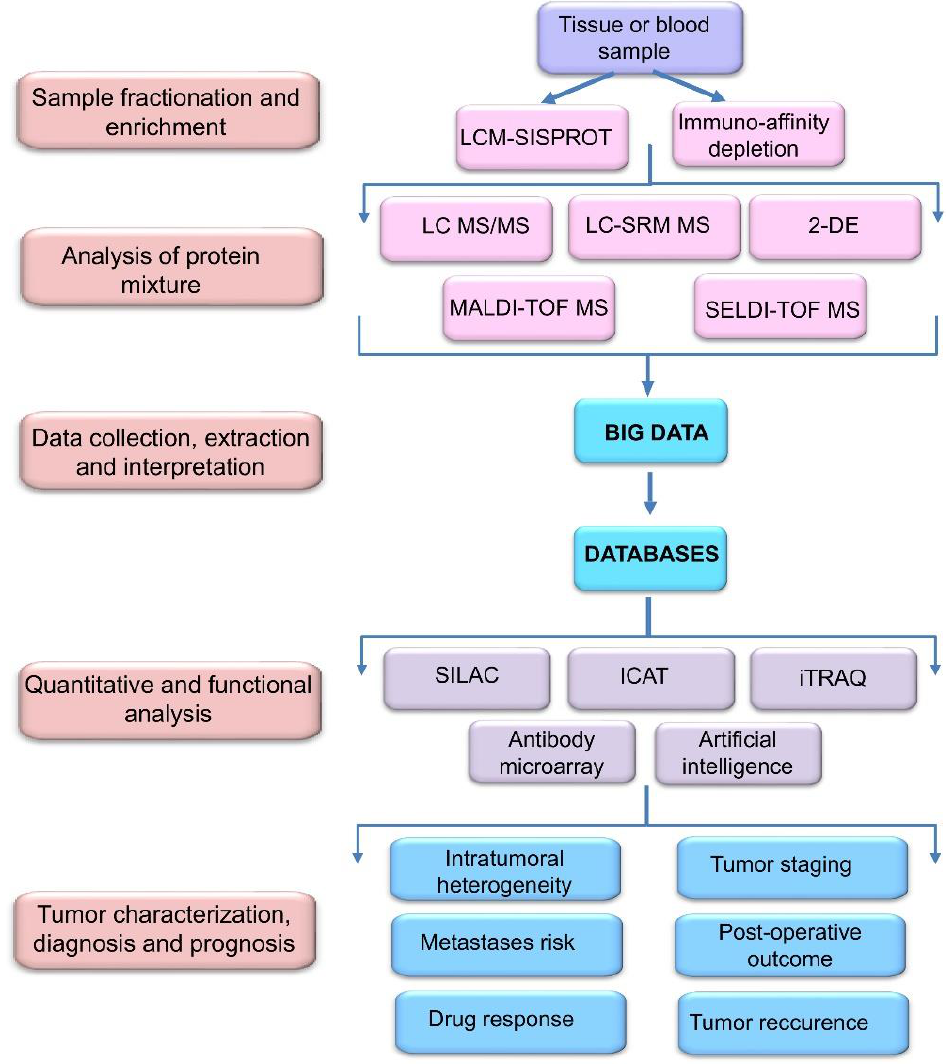
Figure 2. Workflow of biomarker identification, quantification, validation, and verification using proteomic profiling technologies. Tissue and blood samples are first fractionated and enriched using laser capture microdissection spintip-based proteomics (LCM-SISPROT) and immuno-affinity depletion. Then, biomarker candidates are identified using two-dimensional gel electrophoresis (2-DE) and liquid chromatography (LC) in combination with various types of mass-spectrometry (MS) including selected reaction monitoring (SRM), matrix-assisted laser-desorption ionization time of flight (MALDI-TOF) and surface-enhanced laser desorption/ionization time of flight (SELDI-TOF) MS. Large-scale integrated proteomic profiling leads to the accumulation of a huge amount of data (big data), which are collected and stored in special databases for further processing using stable isotope labeling by amino acids in cell culture (SILAC), isotope coded affinity tag (ICAT), and isobaric tags for relative and absolute quantitation (iTRAQ) and other technologies.